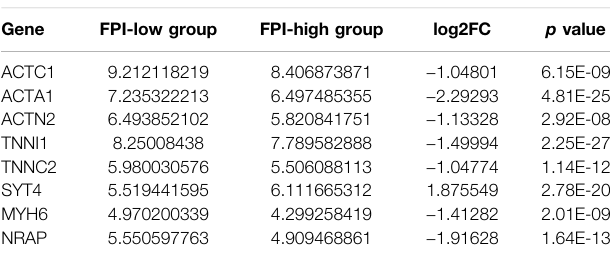
TABLE 6 | Information of eight hub genes.